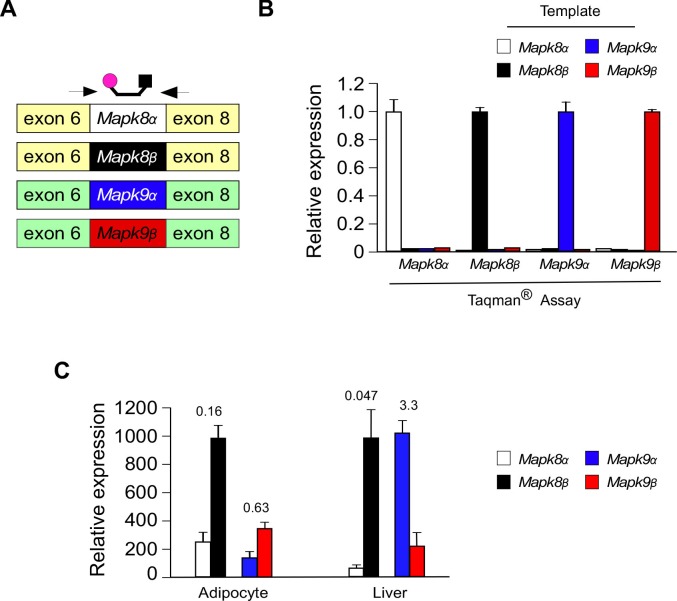
Design and validation of Taqman assays to detect inclusion of the mutually exclusive exons 7a and 7b in Mapk8 and Mapk9 mRNA.(A) Schematic illustration of the design of Taqman assays to detect expression of Mapk8α, Mapk8β, Mapk9α, and Mapk9β mRNA. (B) Taqman assays were performed using 1 ng of cDNA template (Mapk8α, Mapk8β, Mapk9α, and Mapk9β cDNA) and probes designed to detect Mapk8α, Mapk8β, Mapk9α, and Mapk9β. The data presented are the mean ± SEM (n = 3). (C) The relative expression of Mapk8α, Mapk8β, Mapk9α, and Mapk9β mRNA in epididymal adipocytes and hepatocytes was measured by RT-PCR analysis (mean ± SEM; n = 3). The numbers above the bars represents the α/β ratio.